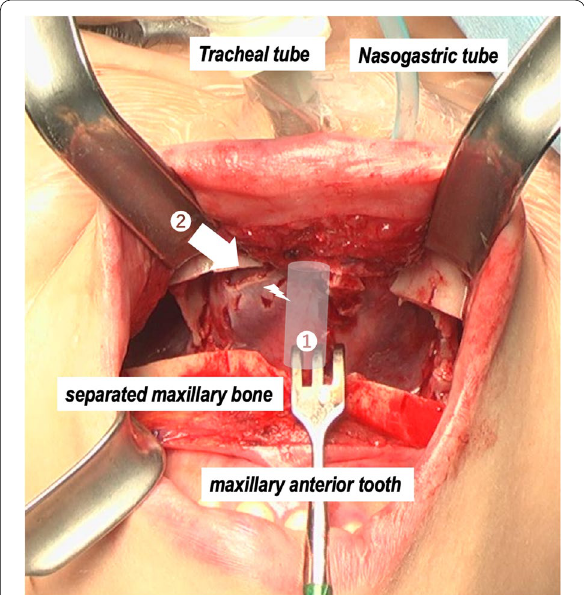
Fig. 2 Image of the oral cavity after maxillary osteotomy with nasotracheal intubation. The nasal cavity was separated from the maxillary bone. Passage of the endotracheal tube was just behind the nasal bottom ① . At the lateral nasal wall, an approximately 1‑cm laceration opened to the nasal cavity ② . Through this laceration, an ultrasonic bone aspirator inadvertently damaged the endotracheal